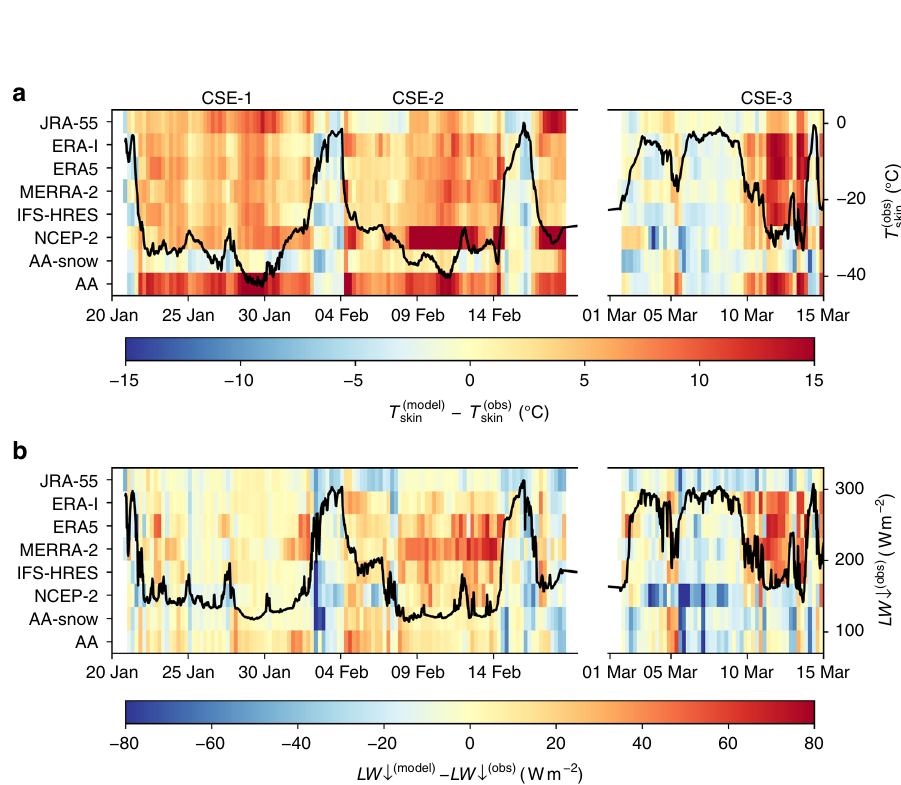
Fig. 2 Observations from the N-ICE 2015 campaign compared to various reanalysis products and model experiments. a Difference between the skin temperature predicted by different models and skin temperature observed during the N-ICE 2015 campaign (background); time series of the measured skin temperature (foreground curve). b Same as a but for downwelling longwave